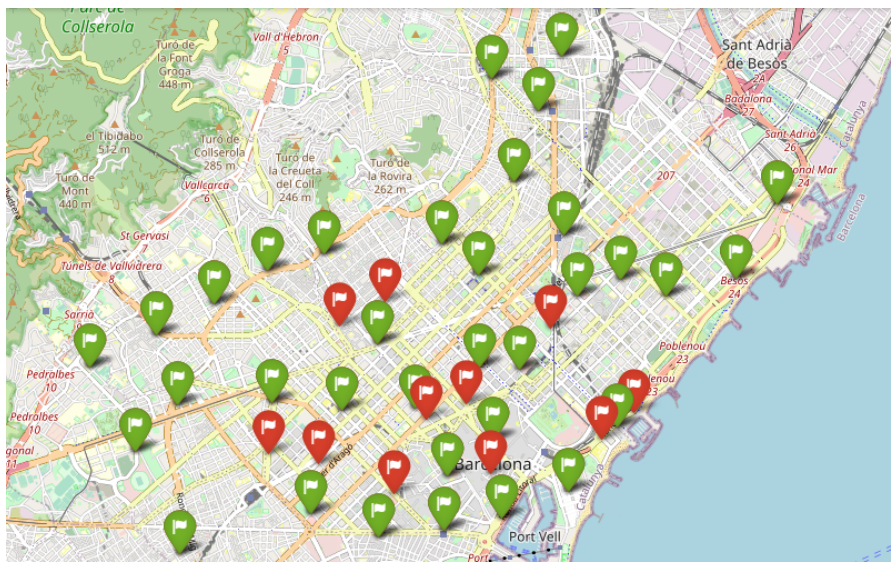
Figure 11. Very Dense, 34 Selected